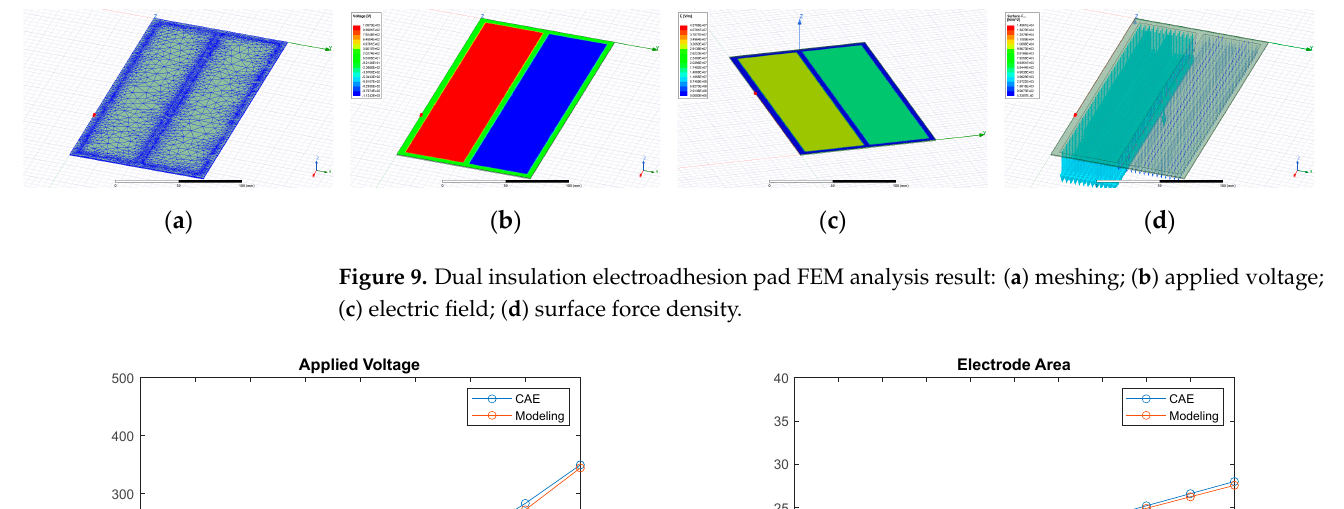
( d ) Figure 8. One insulation electroadhesion pad FEM analysis result: ( a ) meshing; ( b ) applied voltage; ( c ) electric field; ( d ) surface force density.